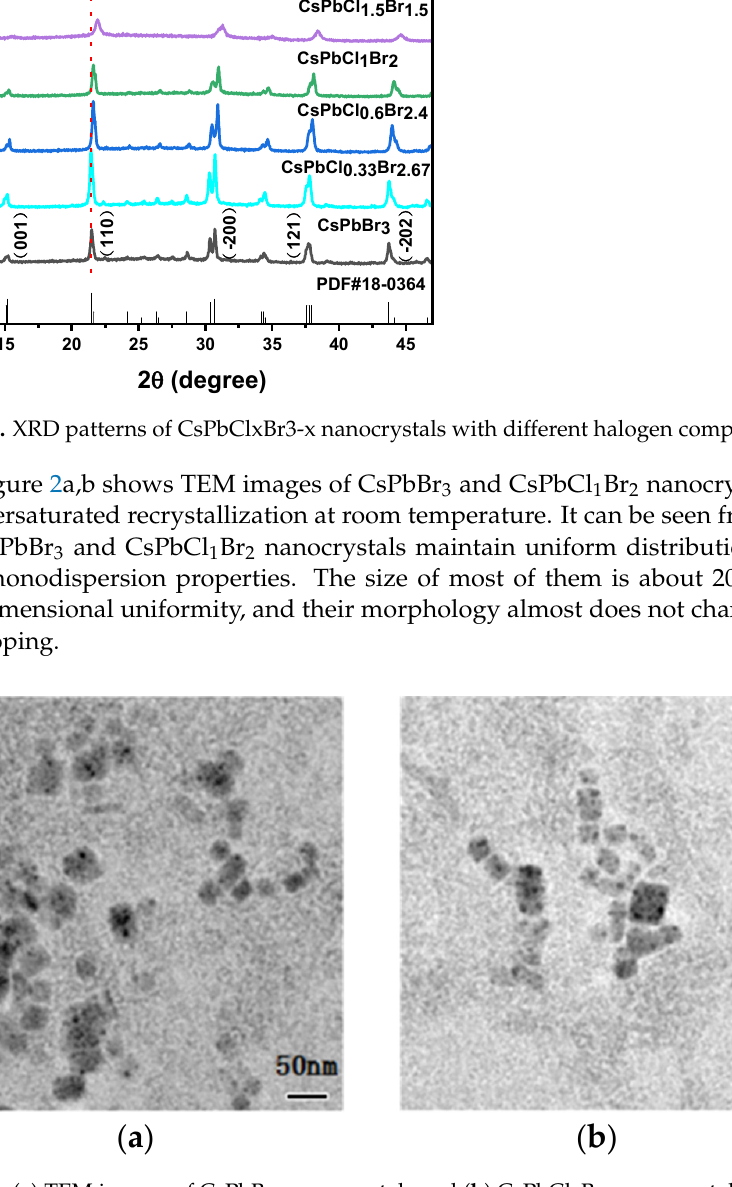
Figure 2. ( a ) TEM images of CsPbBr 3 nanocrystals and ( b ) CsPbCl 1 Br 2 nanocrystals. From the XPS spectrum of Figure 3a–e, the characteristic peaks of Cs 3d, Pb 4d, Pb 4f, Br 3d, and Cl 2p can be clearly observed, among which the characteristic peak of Cl 2p appears, further indicating that the characteristic peak of Tb 3+ still does not appear in the crystal lattice position of bromine successfully incorporated by the chloride ion under the detection limit of XPS measurement. This means that Tb 3+ will not be mixed into the lattice position of CsPbCl x Br 3-x . This not only avoids the pollution of metal ions when metal halides are used as the halogen source, but also solves the problems of incomplete ionization and toxicity of Pb ions when PbCl 2 is traditionally used as the halogen source